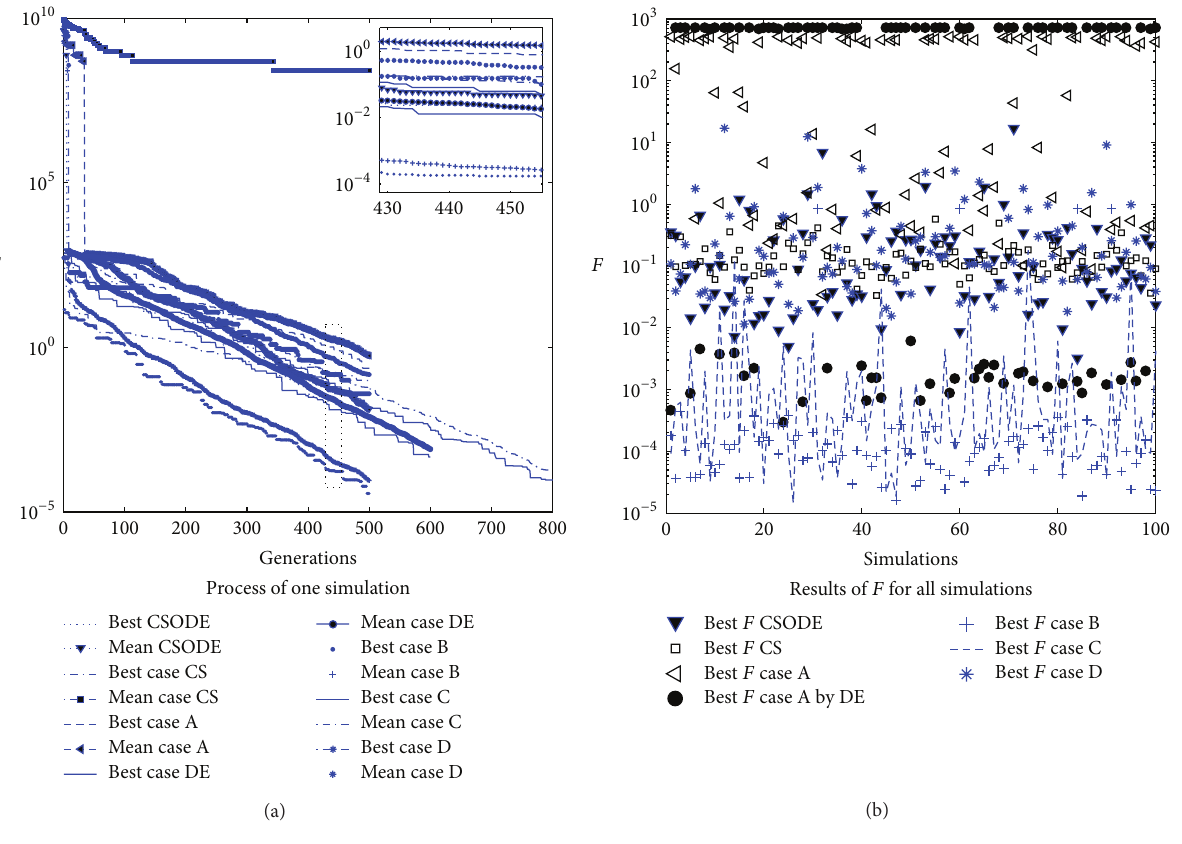
Figure 12: Simulation results for system